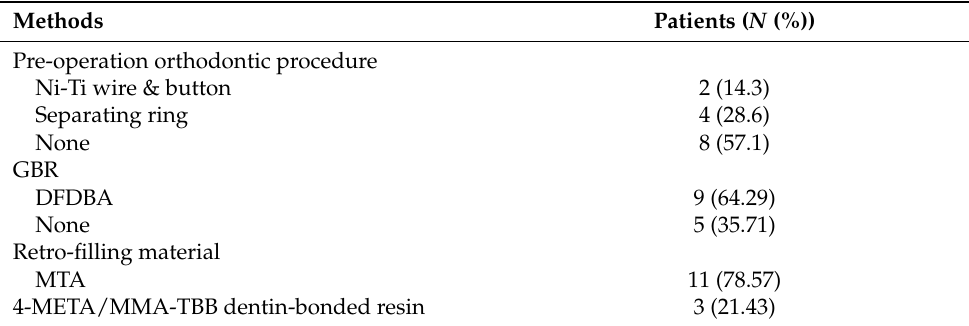
Figure 2. Pre-operative orthodontic procedure. ( A ) An orthodontic button was attached toward the buccal surface of the tooth requiring IR for atraumatic extraction. A nickel – titanium wire was ligated for applying 50 g of orthodontic extrusive force onto the tooth. ( B ) After 2 – 3 weeks, the tooth was extruded in the coronal direction (Arrow: movement of teeth in the coronal direction). Table 2. The methods during the IR procedure.